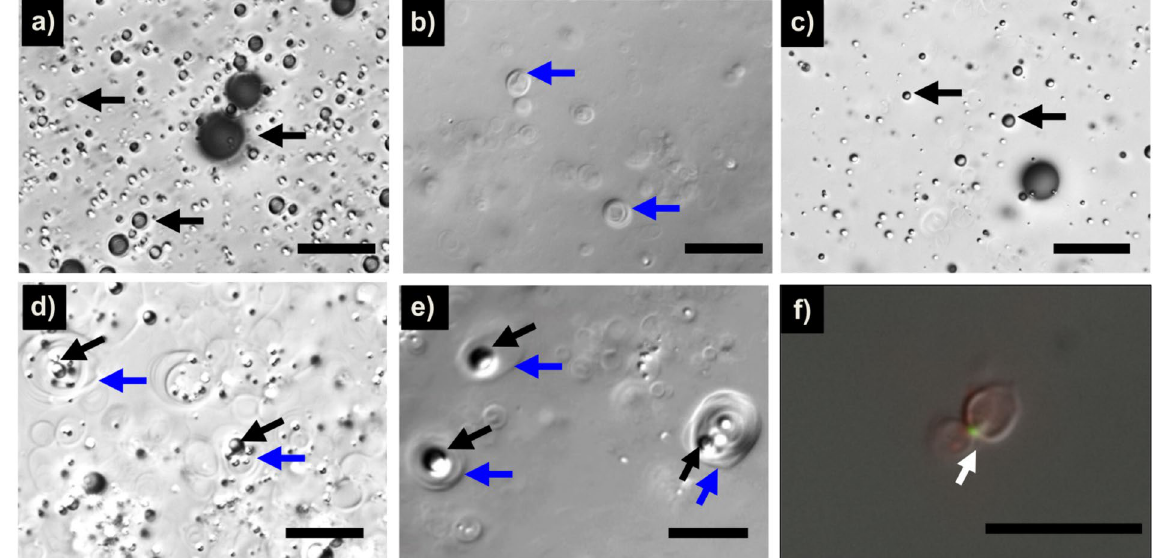
Figure 1. Differential interference contrast microscopy images of ( a ) Definity microbubbles (black arrows), ( b ) OFP t-ELIP reconstituted in undersaturated water (80 ± 2% dissolved gas saturation) showing only liposomes (blue arrows), ( c ) OFP t-ELIP reconstituted in air-saturated water (100 ± 2% dissolved gas saturation) showing microbubbles and a few liposomes near the top coverslip, ( d ) OFP t-ELIP showing a majority of liposomes which appear to entrap microbubble(s) near the bottom slide, ( e ) a close-up view of liposomes that entrap microbubbles, and ( f ) overlaid fluorescence and DIC images of FITC and rhodamine B stained OFP t-ELIP. Scale bar = 15 μ